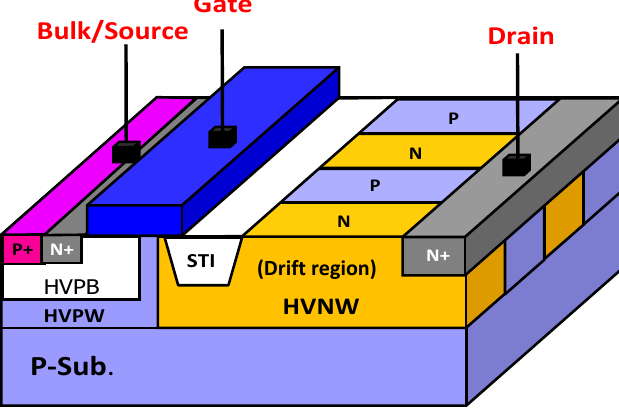
Figure 2. Lateral DMOS with an SJ structure in the drain side.